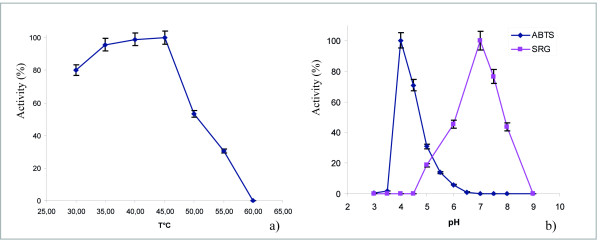
Effect of temperature (a) and pH (b) on the activity of the purified TrLAC1. Various temperatures and pH values were tested under standard conditions by using ABTS "blue diamond" and SRG "pink square" as substrates.